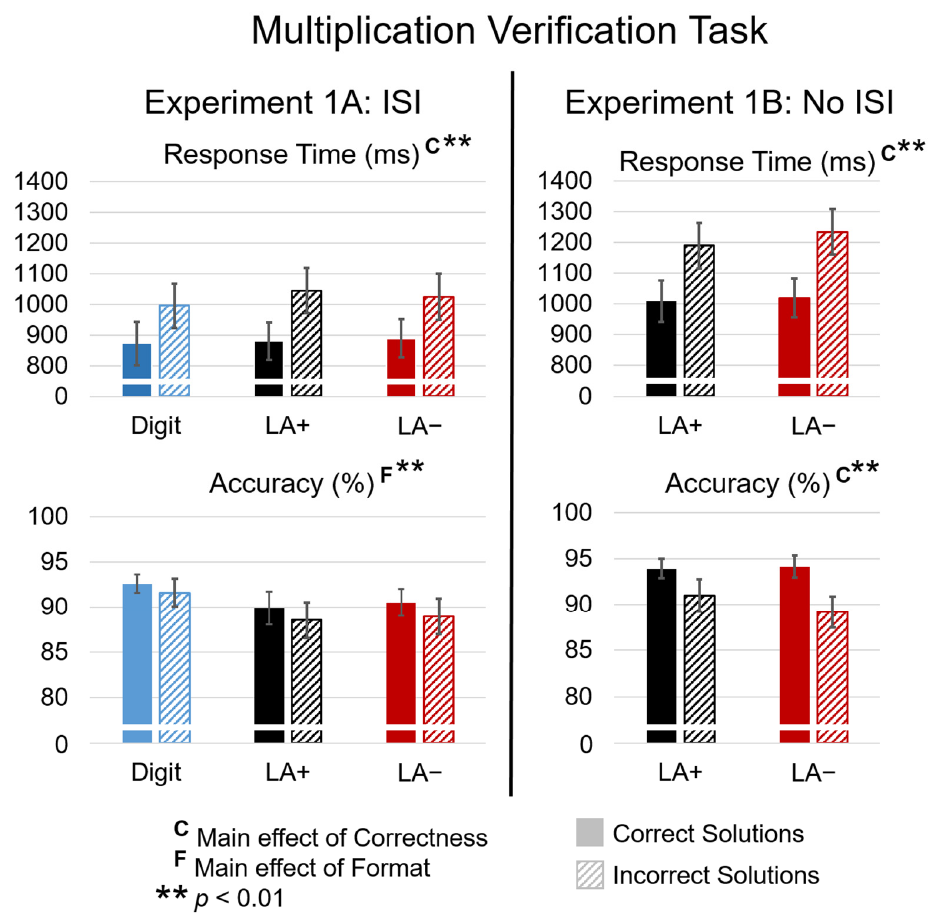
Figure 3. Behavioral results for the multiplication tasks in Experiment 1A ( n = 29) and Experiment 1B ( n = 28). The blue bars represent accuracy and response times for the Digit task (only in Experiment 1A). The language of learning(LA+) and the other language (LA − ) are depicted for both experiments in the black and red bars, respectively. Response time measurements include only trials that participants judged correctly.